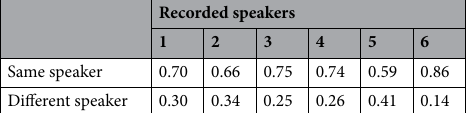
Table 2. Frequencies of speaker ratings in Experiment 1 separated by speakers of the stimuli.